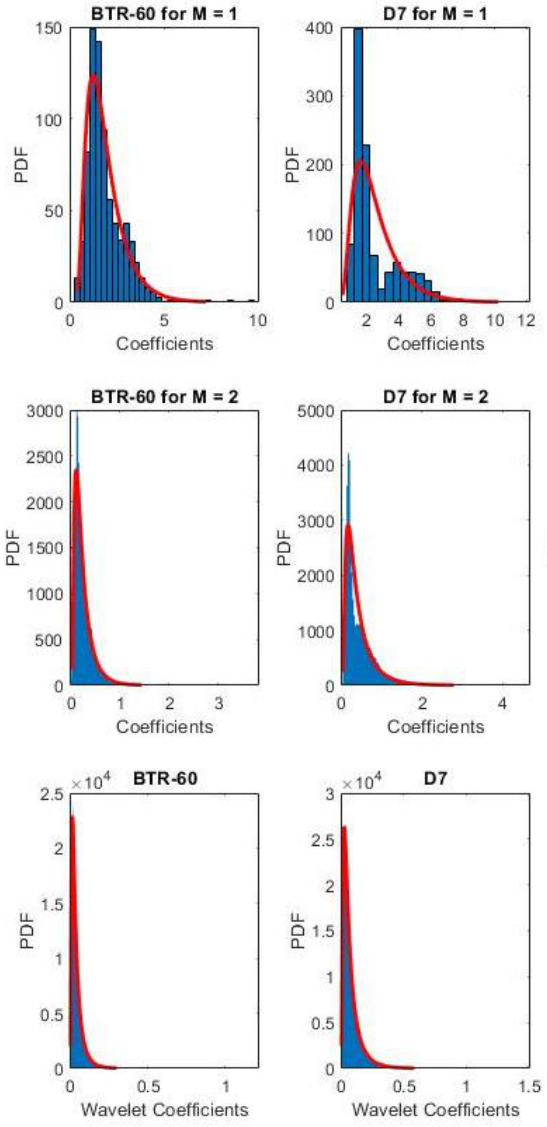
Figure 6. Histogram of MSTAR dataset wavelet coefficients separated by class for each s-layer in a WSN for Q = 1, J = 5, and L = 8: ( Top ) M = 1; ( Middle ) M = 2; ( Bottom ) fitted inverse Gaussian PDF.